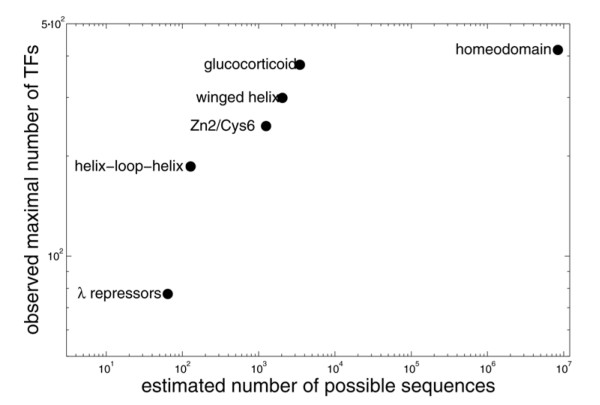
Correlation between the maximal number of transcription factors and number of possible sequences for six super-families, for which details of binding mechanism are known.